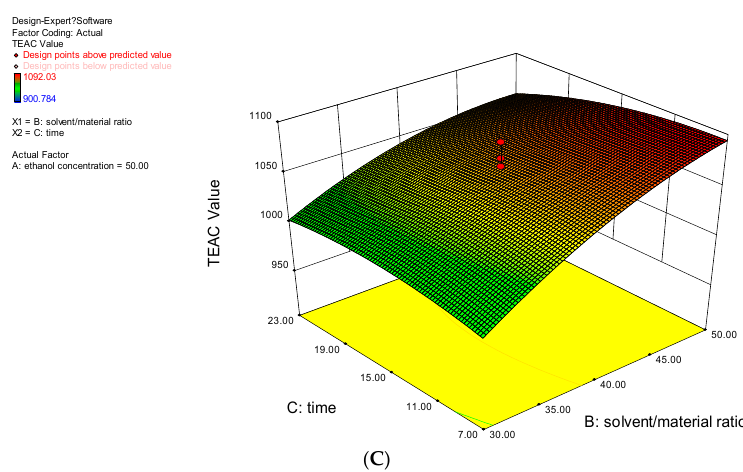
Figure 2. Interaction effects of ethanol concentration and solvent/material ratio ( A ), ethanol concentration and ultrasound irradiation ( B ), solvent/material ratio and ultrasound irradiation time ( C ) on antioxidant activities.